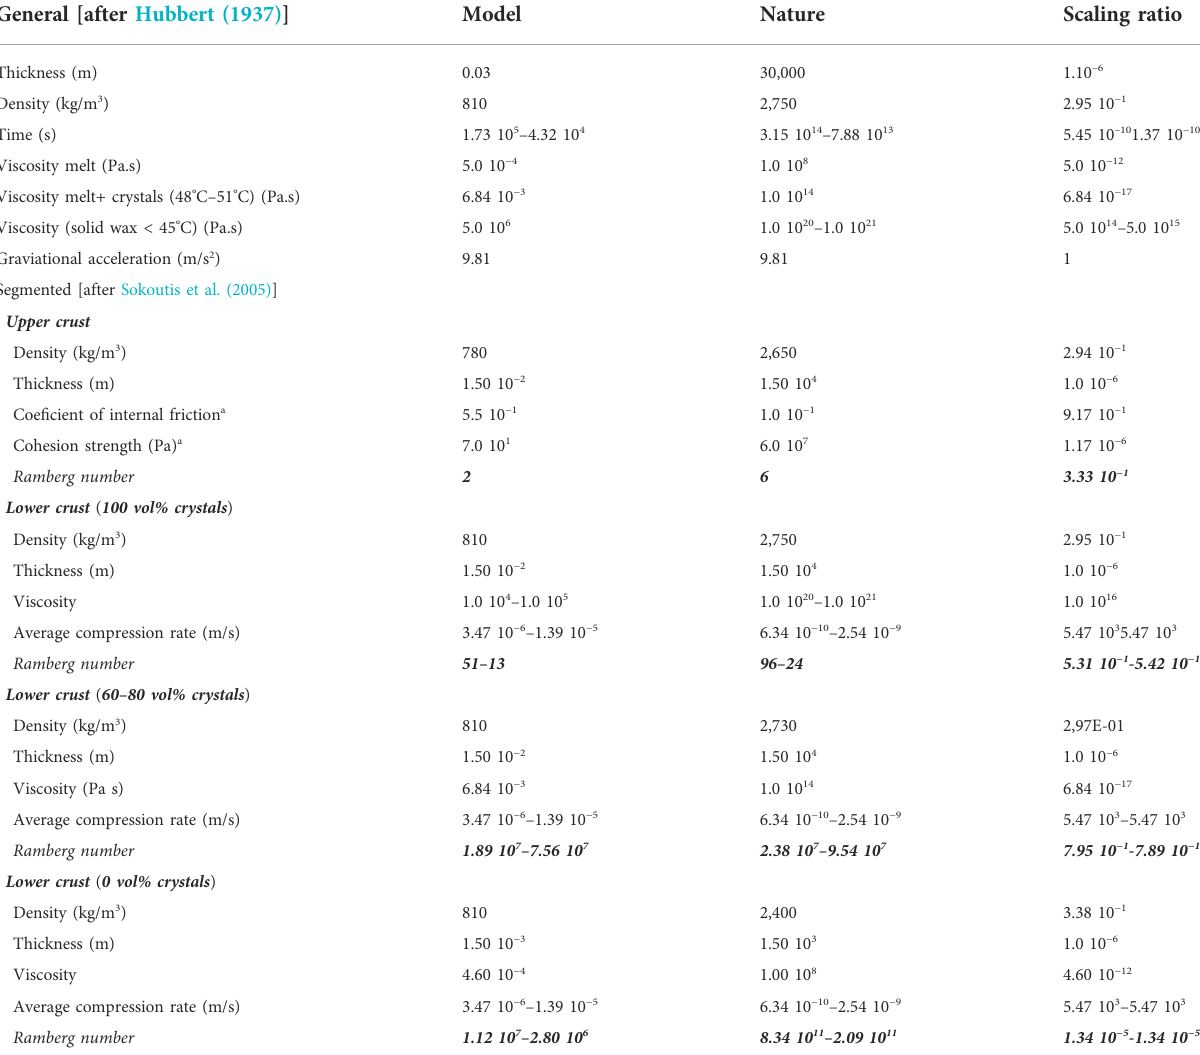
TABLE 1 Modelparameters and scaling. General bulk scaling followed Hubbert (1937) while scaling according to individual segments was performed after Sokoutis et al. (2005), Lehmann et al. (2017) and Krýza et al. (2019). The associated Ramberg numbers are shown at the end of each section (for ranges corresponding to varied parameters). Segmented scaling is supposed to describe the model dynamical accuracy in terms of individual layers. General [after Hubbert